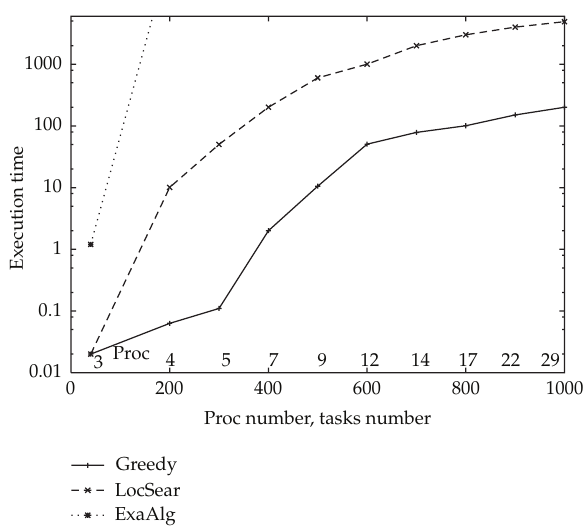
Figure 3: Execution time comparison.